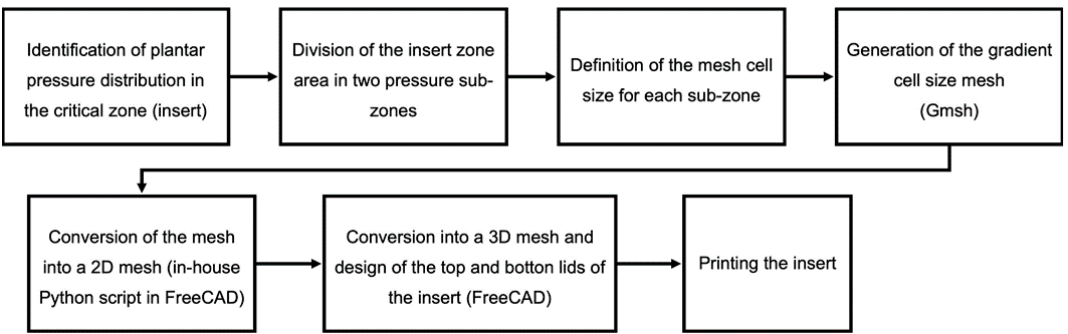
Figure 7. Sequence adopted in the design of the gradient property insole inserts.